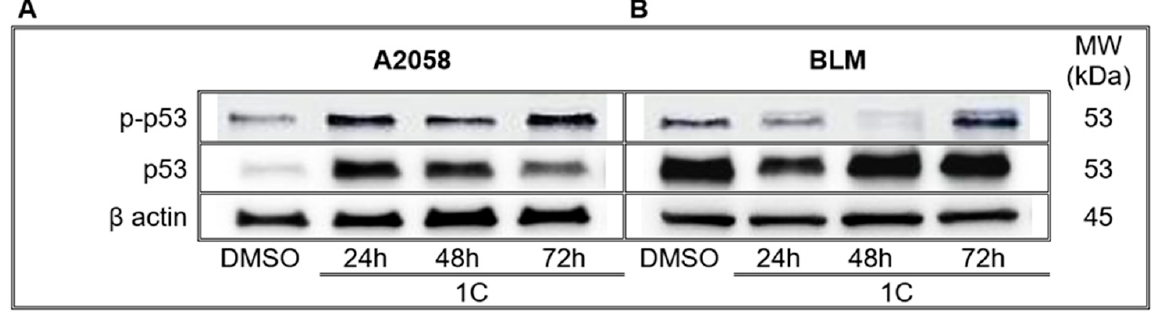
Figure 5. WB analysis of p53 protein in A2058 ( A ) and BLM ( B ) melanoma cells after 24, 48 and 72 h of treatment with chalcone 1C at concentrations of 10 μ mol/L (A2058) and 20 μ mol/L (BLM). Rep- resentative WB.